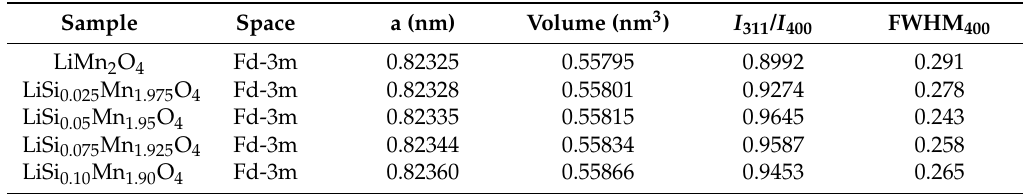
Table 1. Crystal parameters of the LiSi x Mn 2 − x O 4 (x = 0, 0.025, 0.05, 0.075 and 0.10) samples.